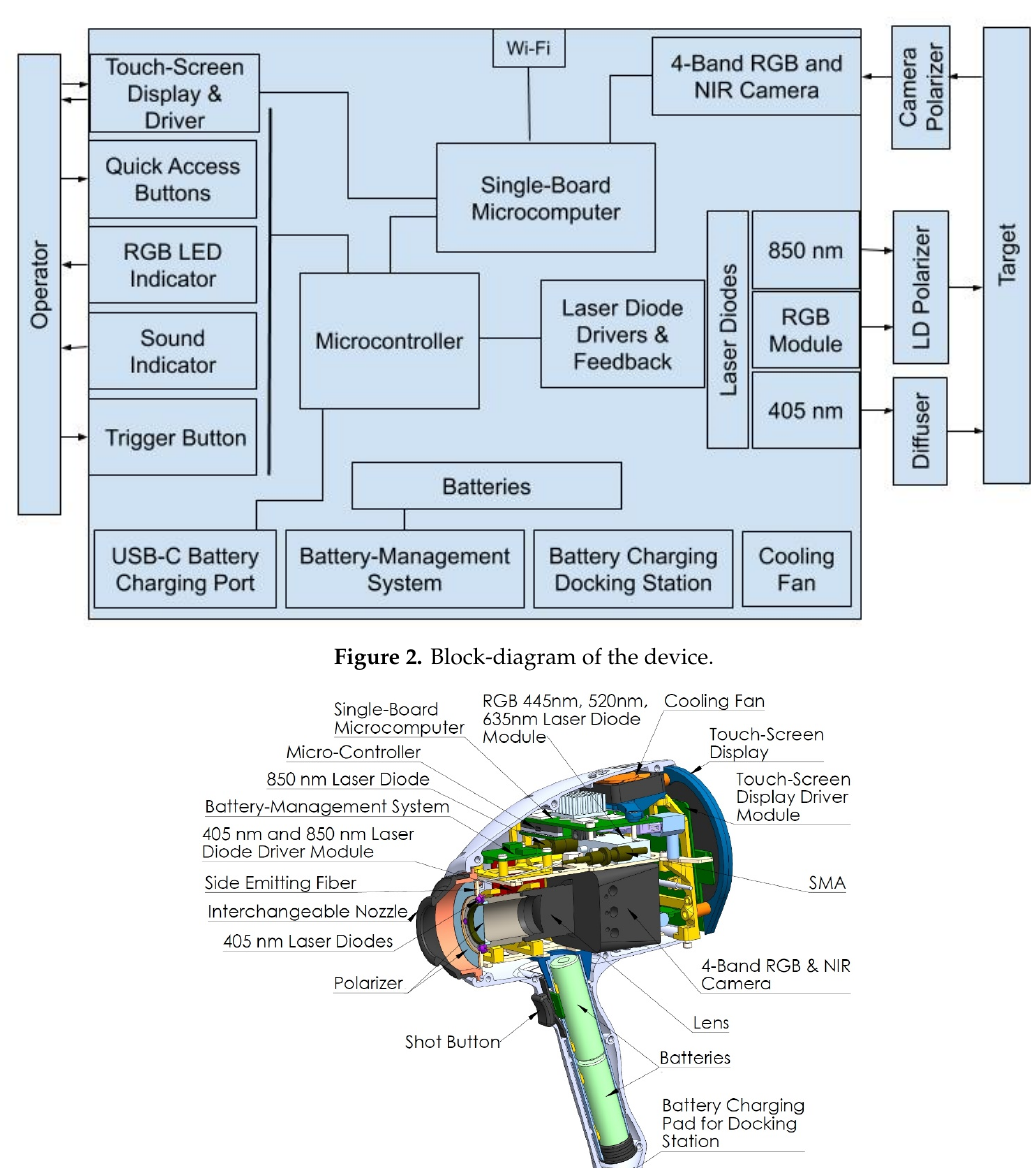
Figure 3. Design scheme of the prototype device.